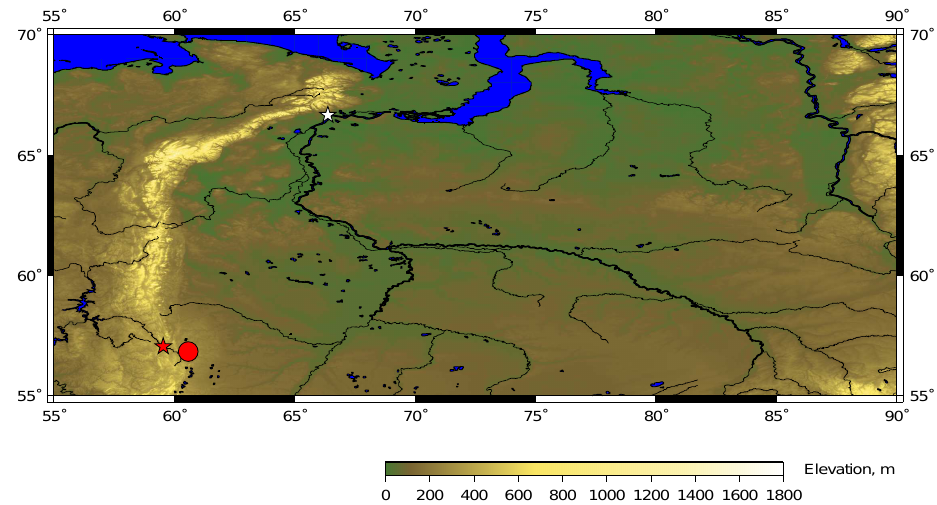
Figure 1. Map of the target region (western Siberia). Kourovka observation site is marked with a red star and Yekaterinburg is marked with a red circle. The white star denotes the future site at